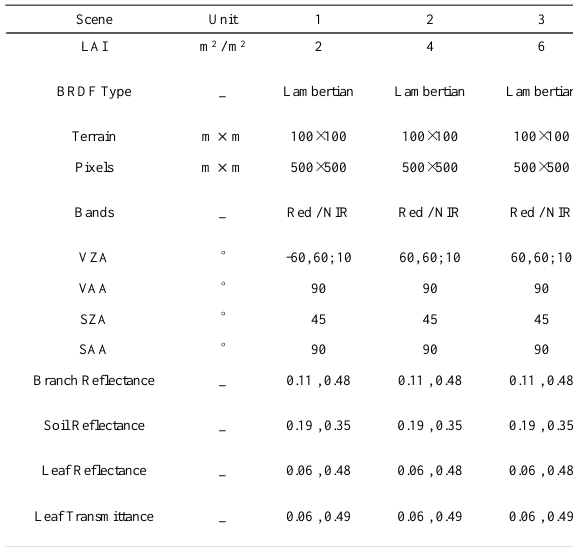
Table 3. Simulation parameter design. Figure 3. Comparison of the simulated BRDF by the LESS model and MCD43A1 BRDF in the (a) red band and (b) NIR band. Figures 4 illustrated the BRDF in red and NIR bands simulated by the LESS model and that calculate from MCD43A1 data using the RTLSR model. The BRDF simulated by LESS and the MCD43A1 BRDF is asymmetric in the red and NIR bands along the principal plane. Canopy reflectance in the backward direction (with VZA < 0°) is lower than that in the forward direction (with VZA > 0°). It is worth mentioning that both model simulations and satellite observations indicate strong hot-spot effect and bowl-edge effect. The hot-spot effect means that canopy reflectance reaches the maximum value when viewing from the sun direction (i.e., VZA = SZA = 45°). The canopy reflectance simulated by LESS and the MCD43A1 canopy reflectance first increase with VZA from -60° to 45°, and then the BRDF simulated by the LESS model decreases next and increases with VZA from 45° to 60°. However, the BRDF of MCD43A1 is increasing with VZA from 45° to 60°. The bowl-edge effect means that canopy reflectance would reach relative high values when VZA is large (e.g., -60° and 60°). In addition, the BRDF simulated by LESS is lower in the red band than MCD43A1, but higher in the NIR band. For example, the hot-spot canopy reflectance at red band and NIR band simulated by the LESS model is 0.12 and 0.44, respectively. The hot-spot canopy reflectance at red band and NIR band based on MCD43A1 data is 0.15 and 0.36,